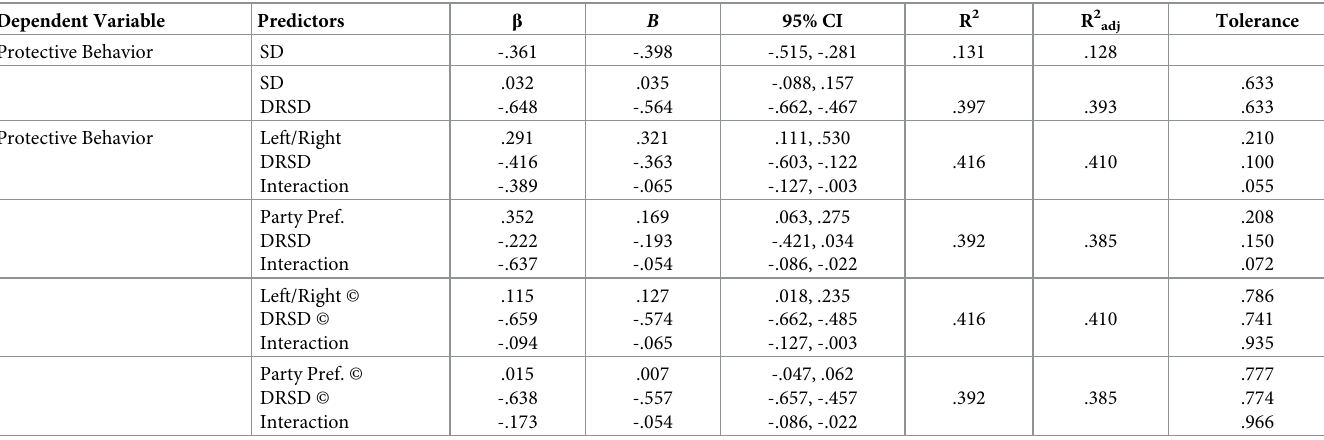
Table 4. Regression analyses predicting protective